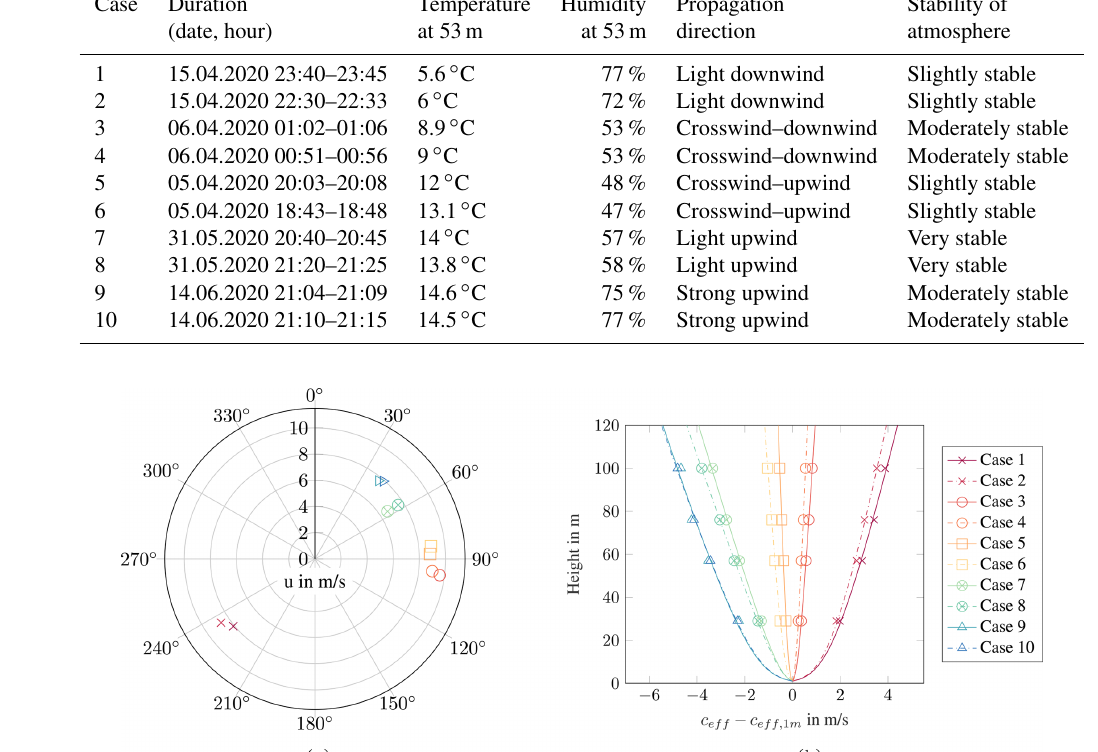
Figure 4. (a) Distribution of measured wind speed and wind direction at 100 and 95m height respectively. (b) Derived profiles of effective sound speed (lines) based on measured data at four heights (markers), normalised with the effective sound speed at 1m. The wind directions are related to the microphone positions so that a direction of 0 ◦ indicates upwind conditions, whereas a direction of 180 ◦ represents downwind conditions. For both graphs the legend on the right side is